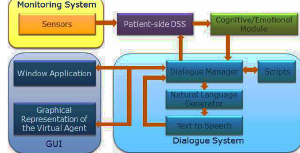
Figure 1. System